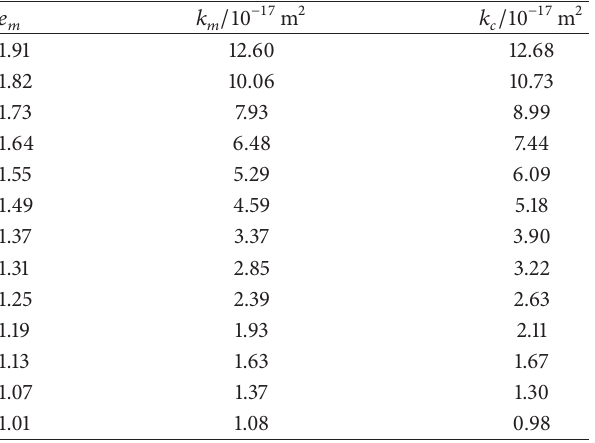
Table 2: Calculated and measured permeabilities of sea clay using the R-W